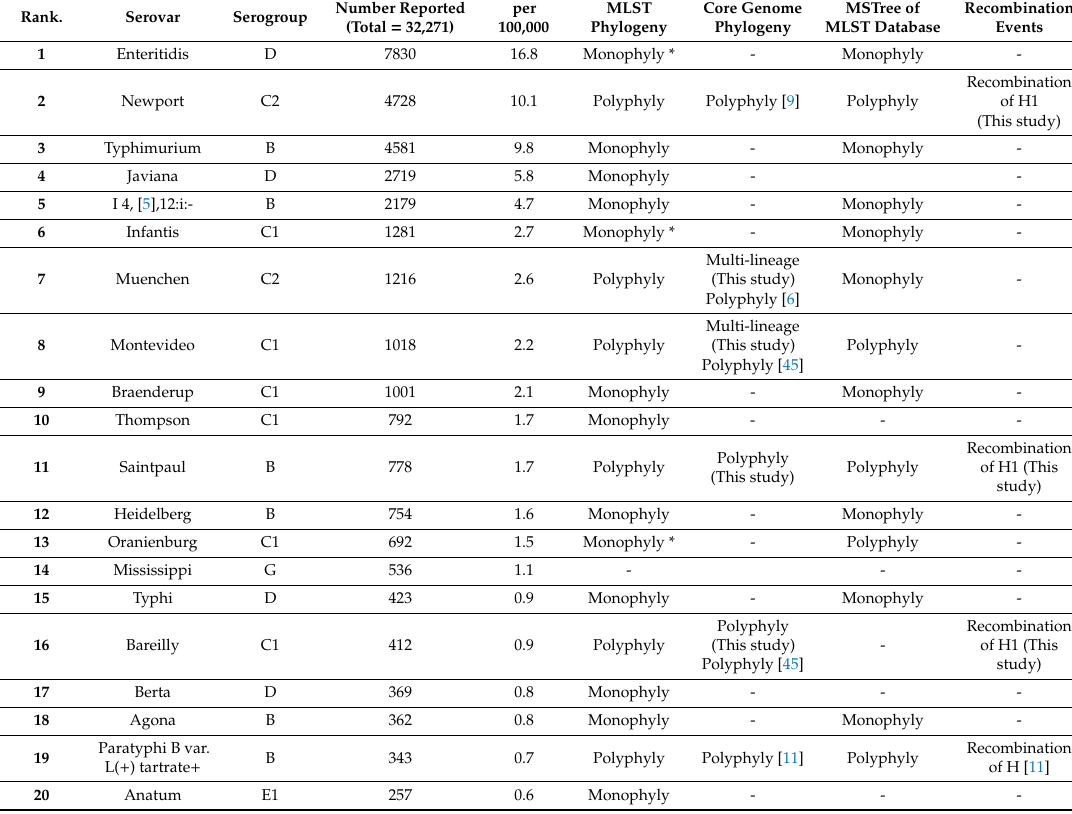
Table 1. List of top 20 Salmonella serovars attributed to human illness in the USA a .